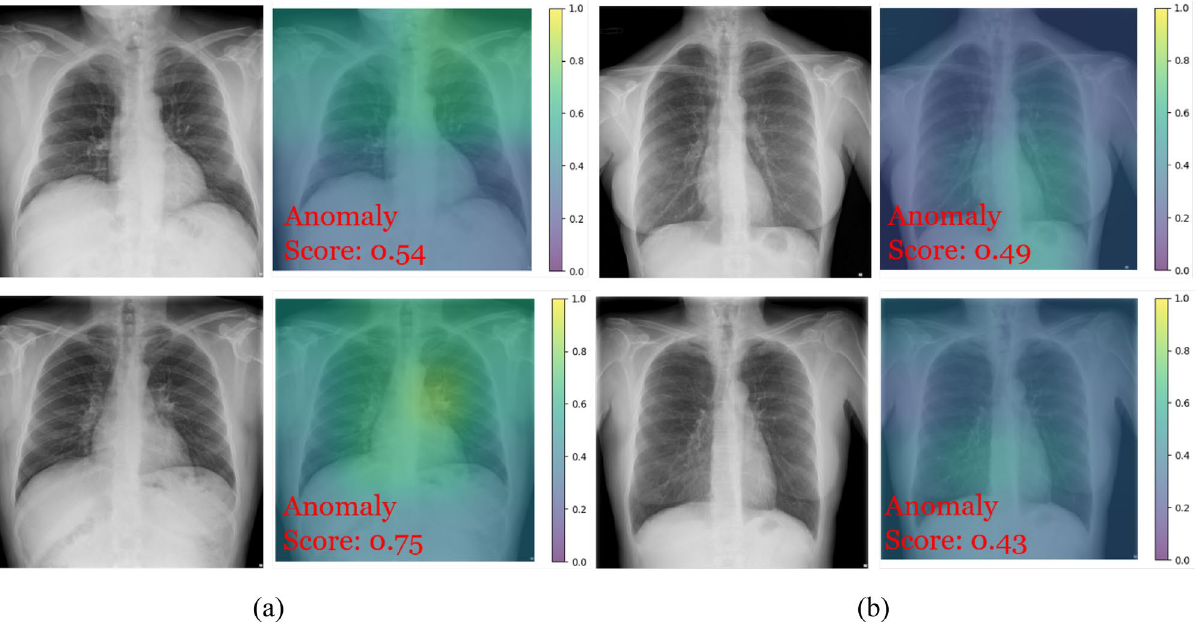
Figure 7. Radiographs of selected misclassified examples—the anomaly scores were generated by the proposed method that showed the best performance in the experiments: ( a ) Truth label: normal, predicted label: abnormal; ( b ) truth label: abnormal, predicted label: